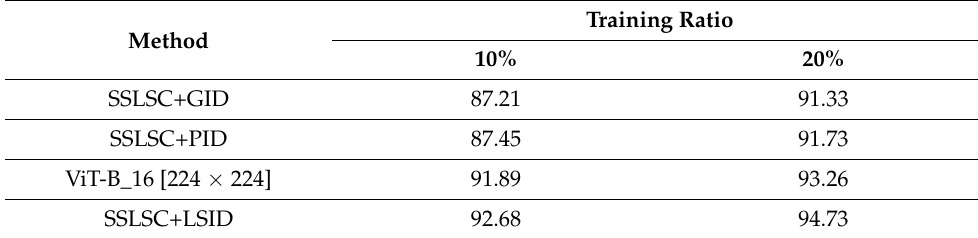
Table 4. OA (%) of experiment on NWPU with different pre-training